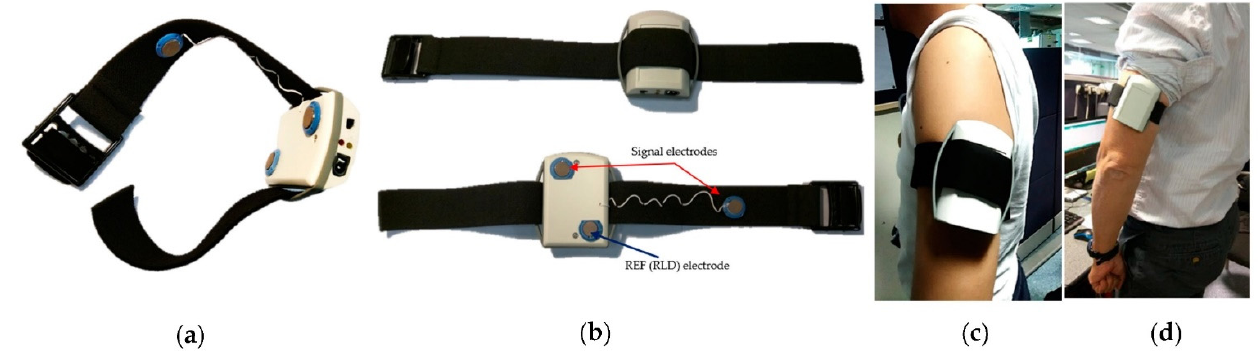
Figure 2. ( a , b ) show the electrode arrangement and the appearance of the wearable device; ( c , d ) show the scene of a person wearing an arm-type wearable ECG monitoring device [20].